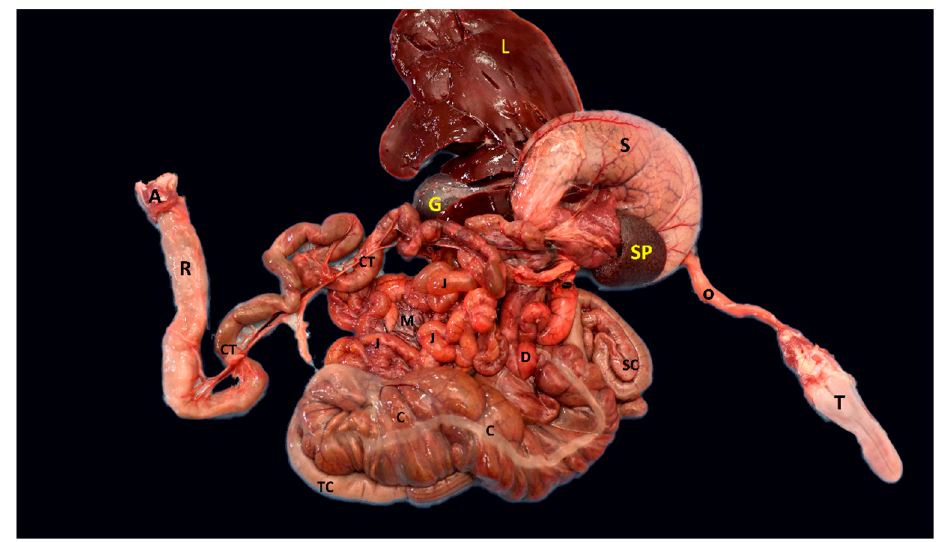
Figure 3. Photograph showing the anatomical view of the gastrointestinal tract of an adult male D.